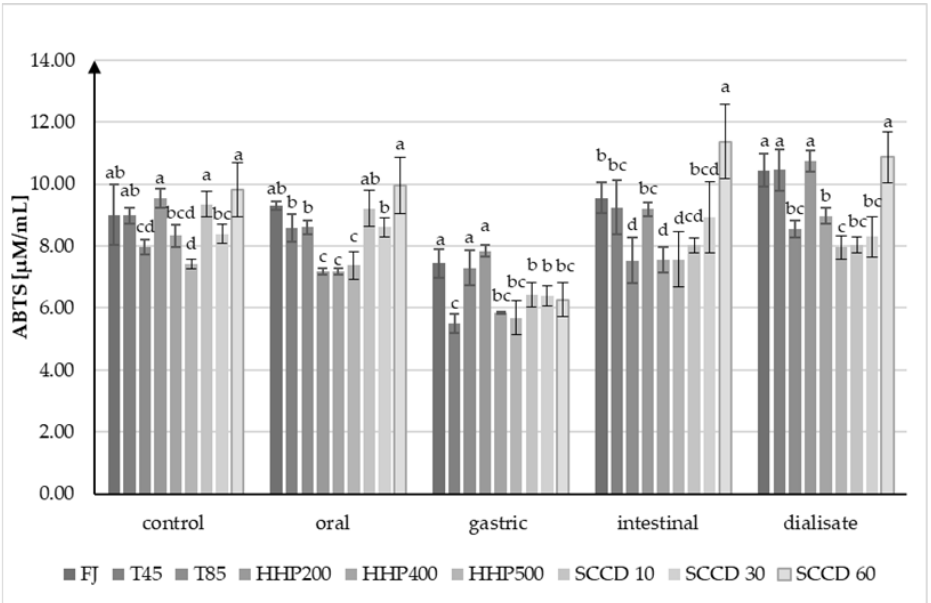
Figure 5. Resu lts of ABTS•+ analysis of antioxidant properties (AC) of beetroot juice after different Figure 5. Results of ABTS • + analysis of antioxidant properties (AC) of beetroot juice after different treatments on every stage of simulated digestion. FJ — untreated juice; T45 — thermal treatment of treatments on every stage of simulated digestion. FJ—untreated juice; T45—thermal treatment sample at 45 °C; T85 — pasteurized sample at 85 °C; HHP200 — sample subjected to HHP at 200 MPa; of sample at 45 ◦ C; T85—pasteurized sample at 85 ◦ C; HHP200—sample subjected to HHP